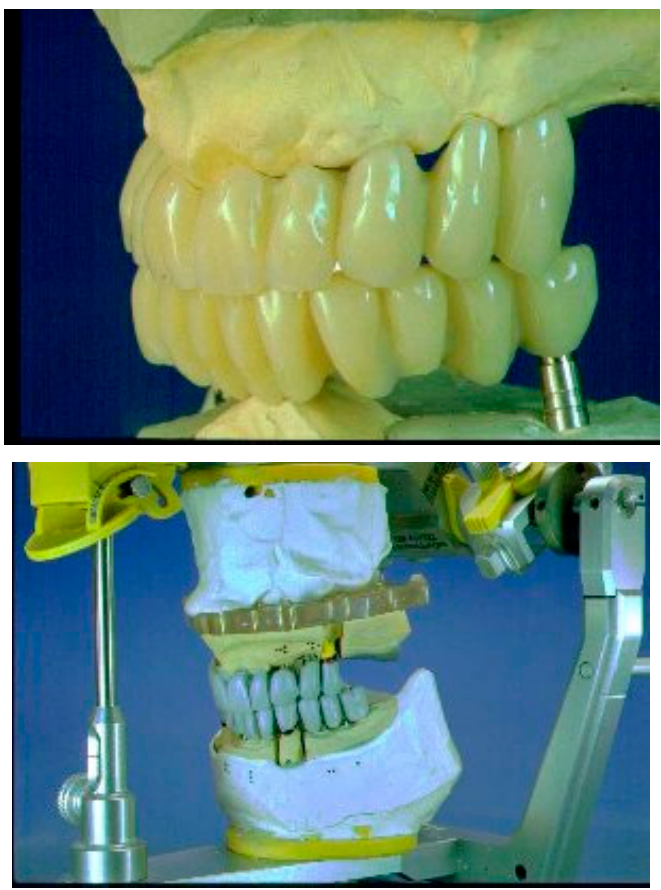
Figure 3. Occlusal line and test on articulator.